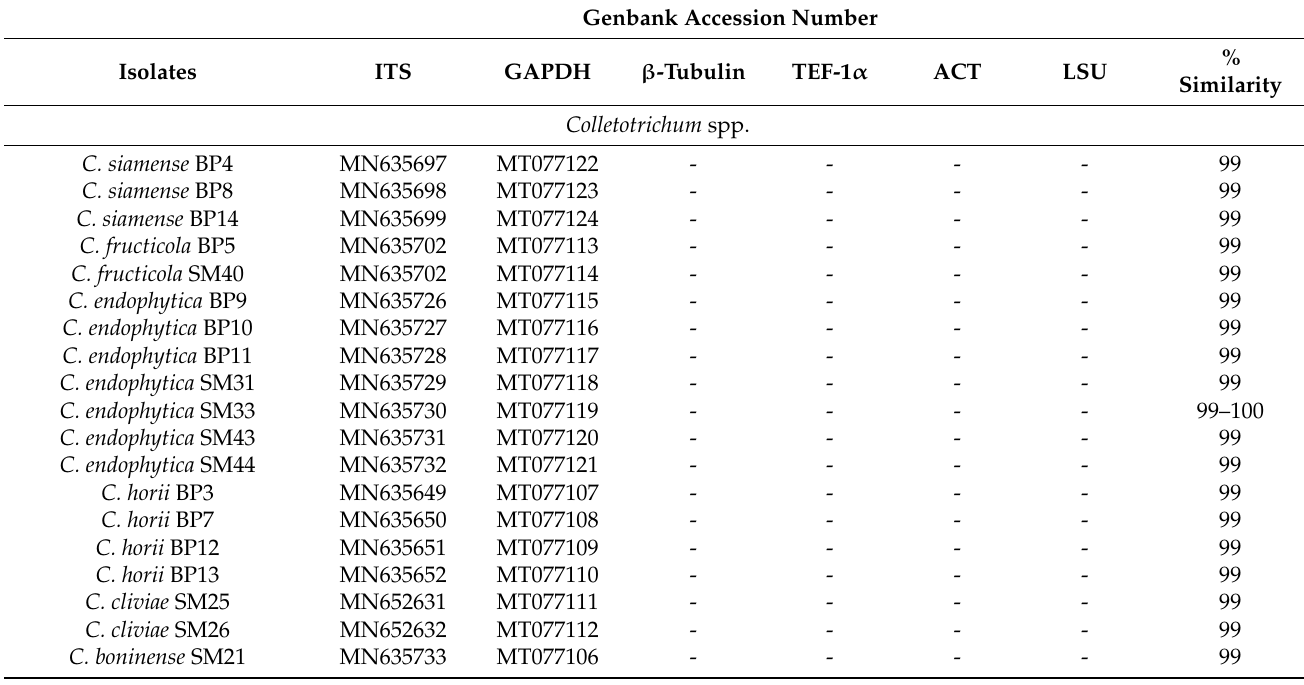
Table 3. Molecular identification of endophytic fungi isolated from C. castaneus